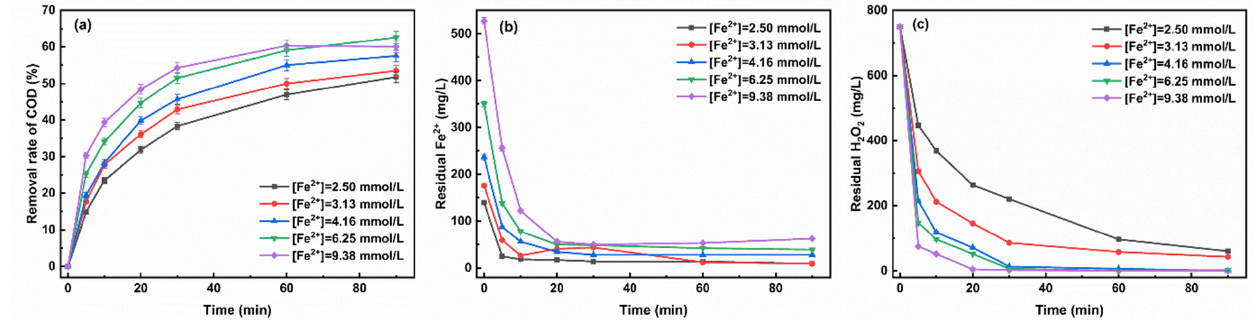
Figure 3. Influence of initial concentration of Fe 2+ on COD removal rate ( a ), the residual concentration of Fe 2+ ( b ), and the residual concentration of H 2 O 2 ( c ).